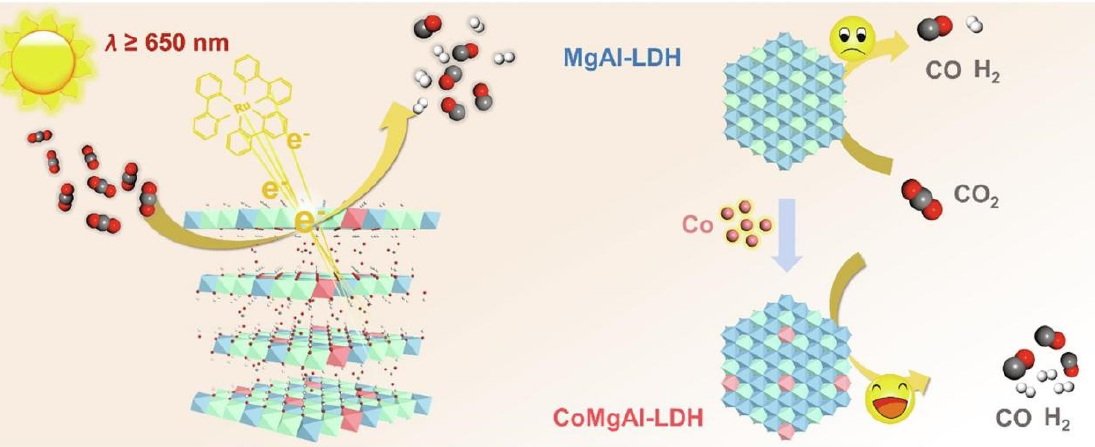
Figure 6. Schematic diagram for MgAl-LDH and CoMgAl-LDH for CO 2 photoreduction to generate CO and H 2 under λ ≥ 650 nm combining with a Ru complex [85].